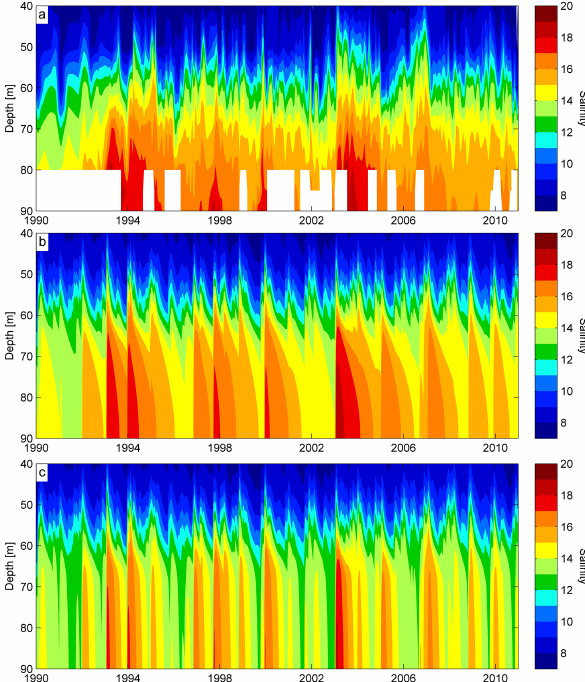
Figure 5. (a) The observed salinity from BY4, (b) the modeled salinity (reference run) and (c) the modeled salinity when pumping 1000m 3 s − 1 from 30m depth down to